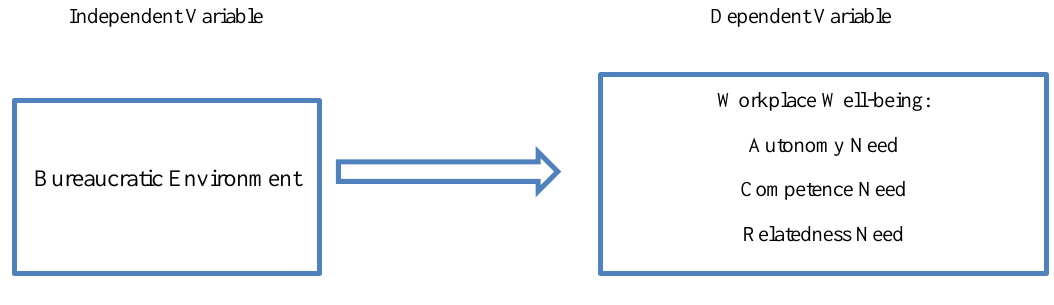
Figure 1: The conceptual framework reflects the relationship between the bureaucratic environment and workplace well-being. Workplace well-being is dependent on the bureaucratic environment; Source: Langer, et.al (2019);Nishimura & Zuzuki (2016) Statement of the